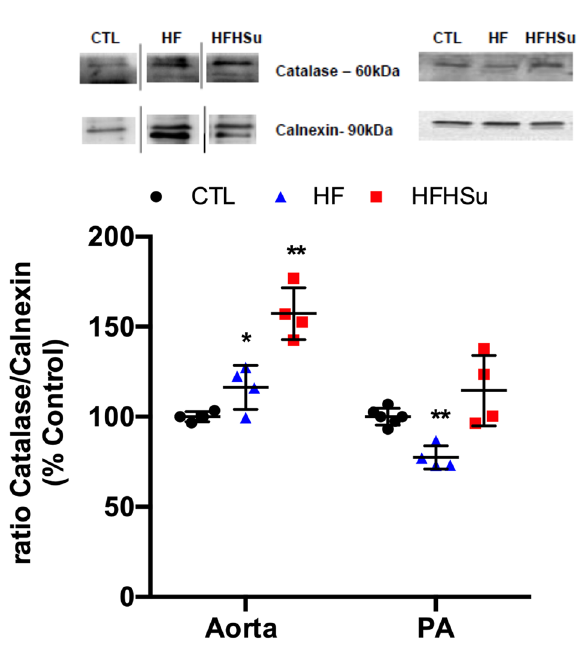
Figure 7. Effect of prediabetes and early phase type 2 diabetes on catalase expression. Average expression of catalase (60 kDa), and the loading protein calnexin (90 kDa) in the aorta and pulmonary artery (PA) of control (n = 4–6), HF (n = 4) and HFHSu (n = 4) animals. Representative western blots for each protein studied are depicted above the respective graphs. The representative bands were cropped due to the sample order in the membrane. For complete membrane image see Supplementary data. Values are presented as scatter plots ± SD; One-way ANOVA with Dunnet’s comparison test. * p < 0.05 and ** p < 0.01 versus control